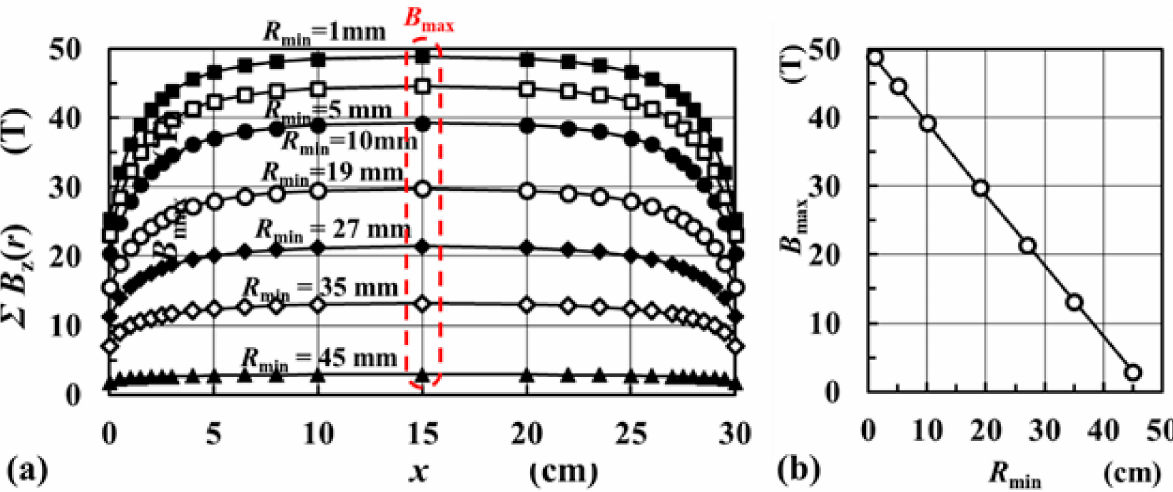
Figure 10. ( a ) Variation in Σ B z ( r ) – x profiles with R min . ( b ) Variation in B max : the maximum value Σ B z ( r ) at x = 15 mm with R min .